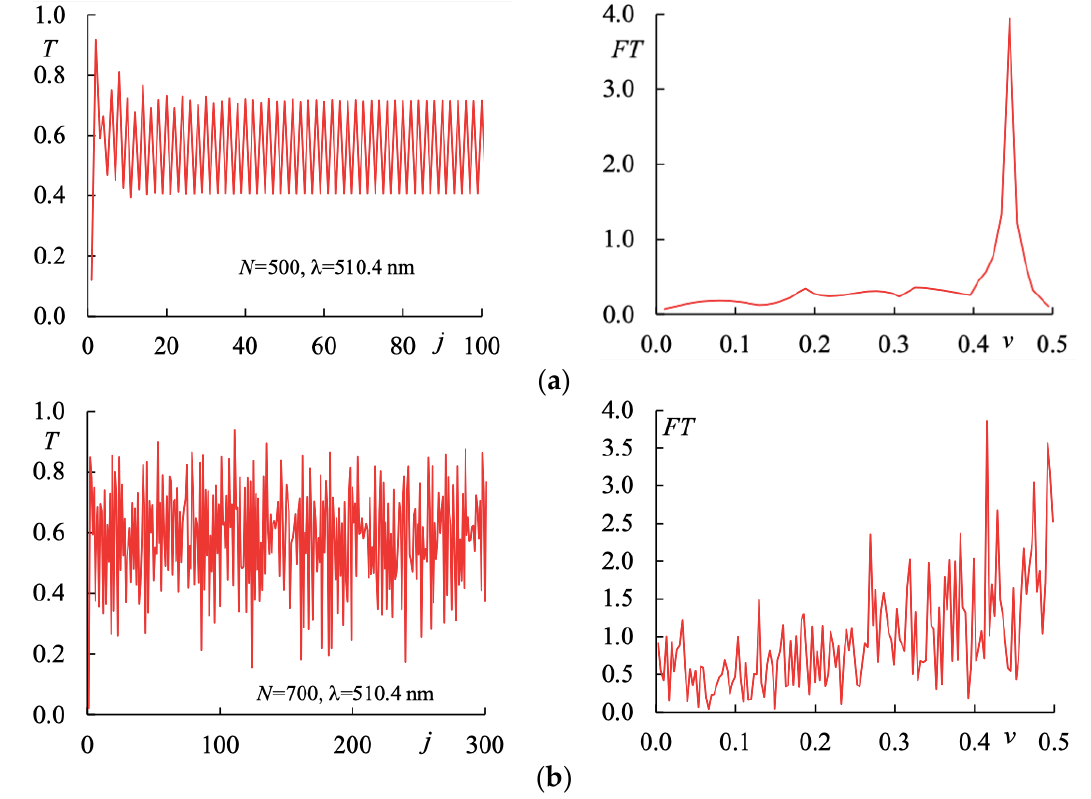
Figure 4. The transmittivity vs. the index j (left curve) and the corresponding Fourier transform (FT) (right curve) on the red side edge of the Bragg resonance at λ 2 = 510.4 nm. ( a ): N = 500, leading to stable oscillations with a narrow range of frequencies shown by FT; ( b ): N = 750, leading to unstable values for the transmission confirmed by FT.